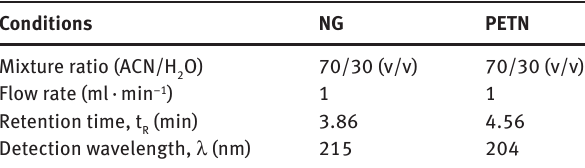
Table 1: Experimental conditions for detecting NG and PETN by HPLC.